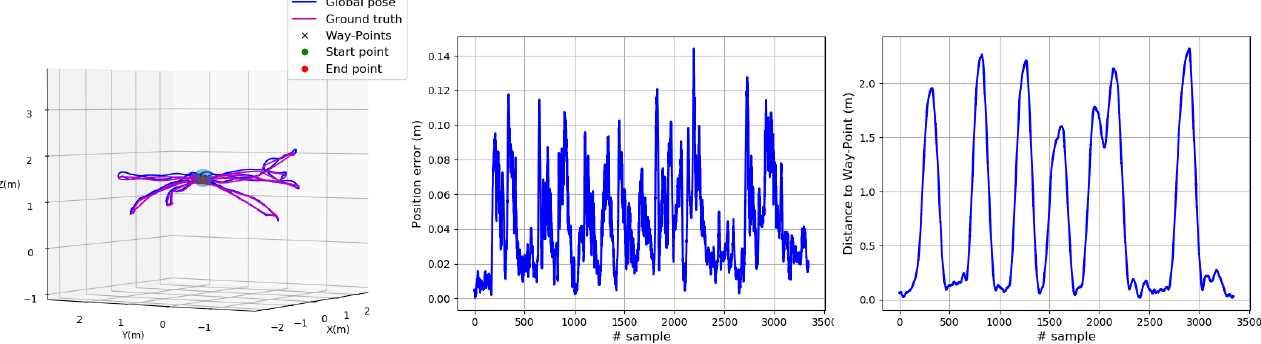
Figure 12. Keep-position experiment: ( left ) estimated and true paths, ( middle ) position estimation error, ( right ) distance to the return position. (All units are in